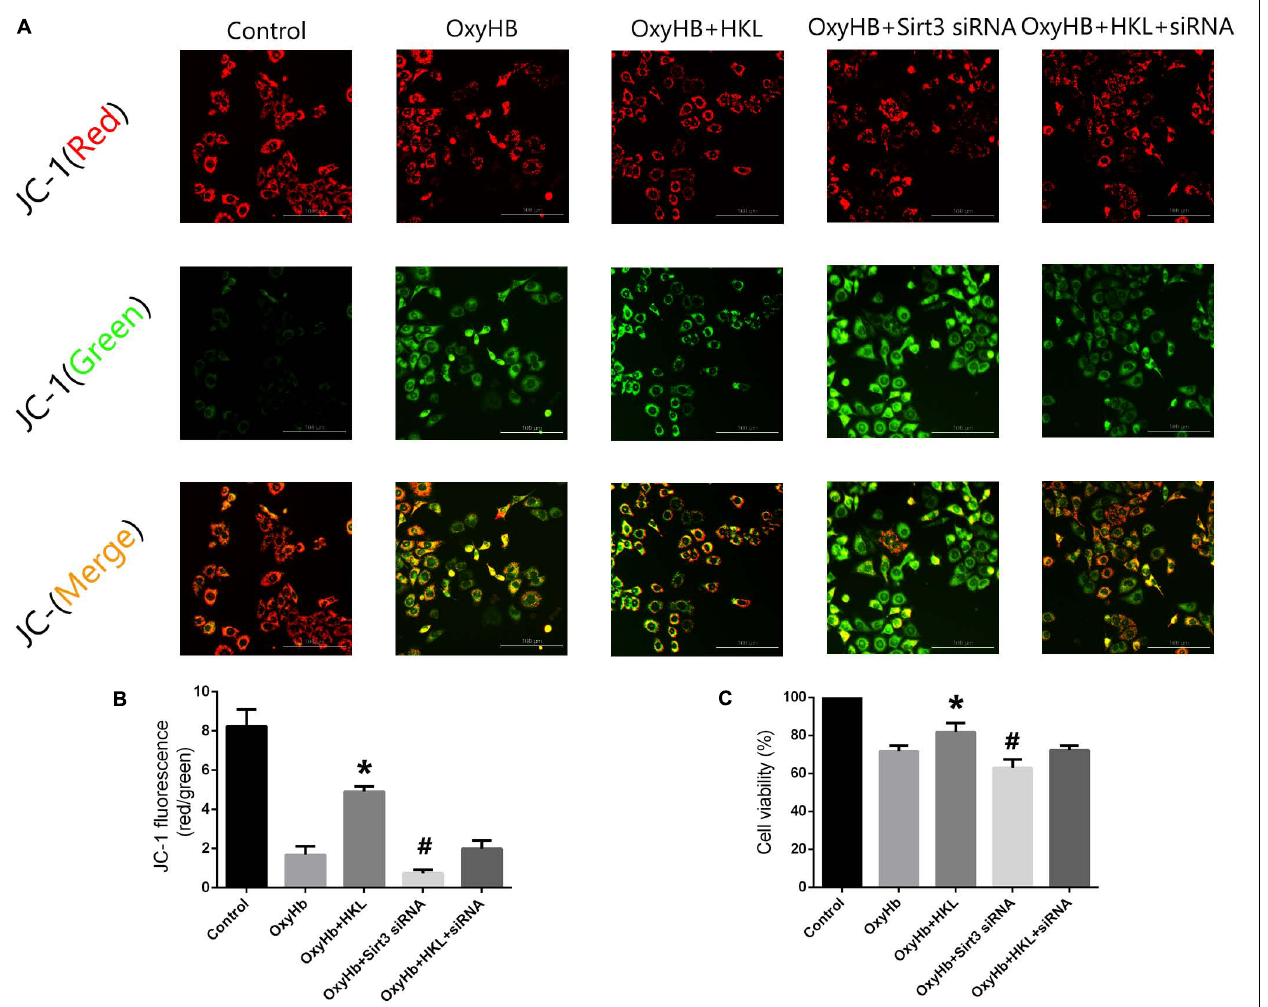
FIGURE 5 | Measurement of (cid:49) ψ m and cell viability in SH-SY5Y cells. (A) Representative JC-1 staining pictures of SH-SY5Y cells. (B) Quantification of JC-1 fluorescence intensity (red/green florescent area), Scale bars: 100 µ m. (C) Cell viability. ∗ P and # P < 0.05 versus the rest groups ( n = 6 in each